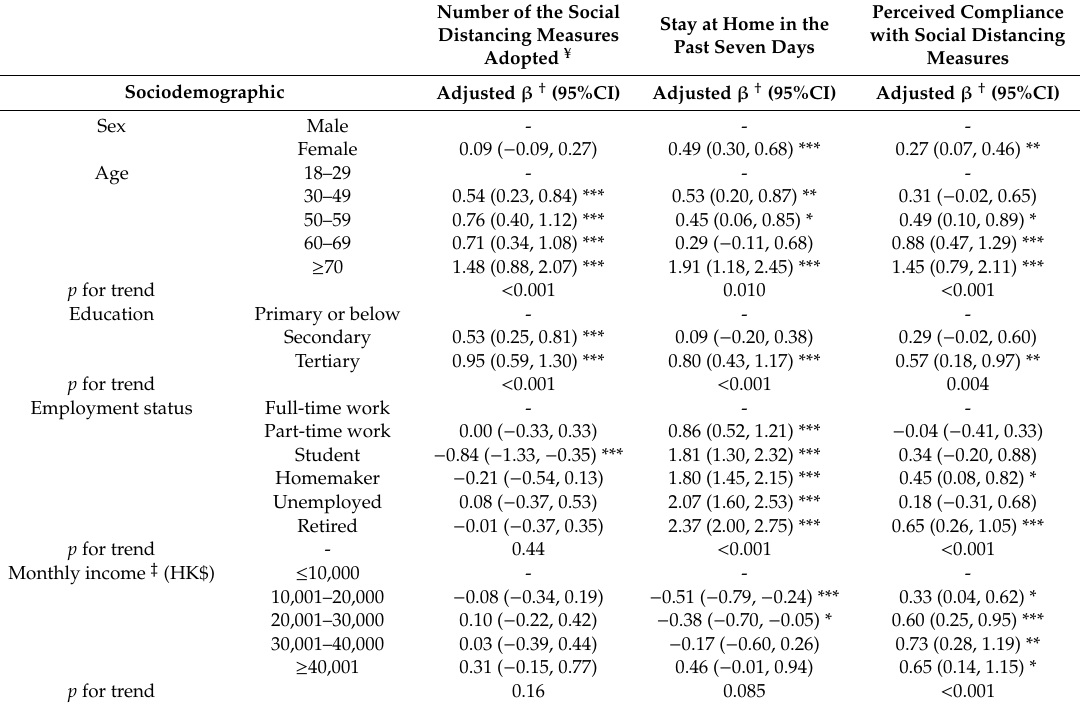
Table 3. Social distancing measures and perceived compliance by sociodemographic factors.